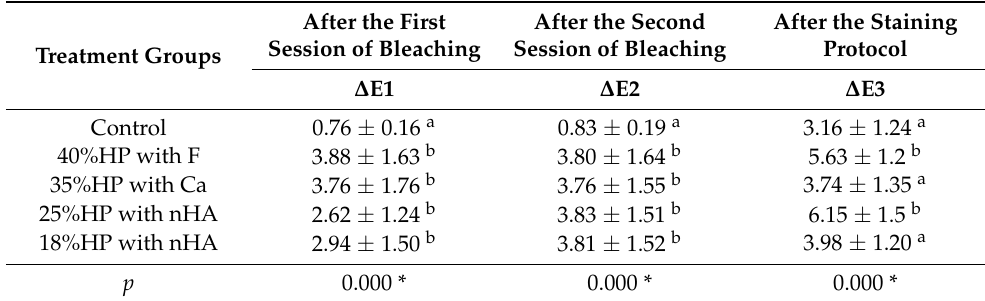
One-way ANOVA test * p < 0.05. Different letters in the columns show the statistical difference ( p < 0.05).